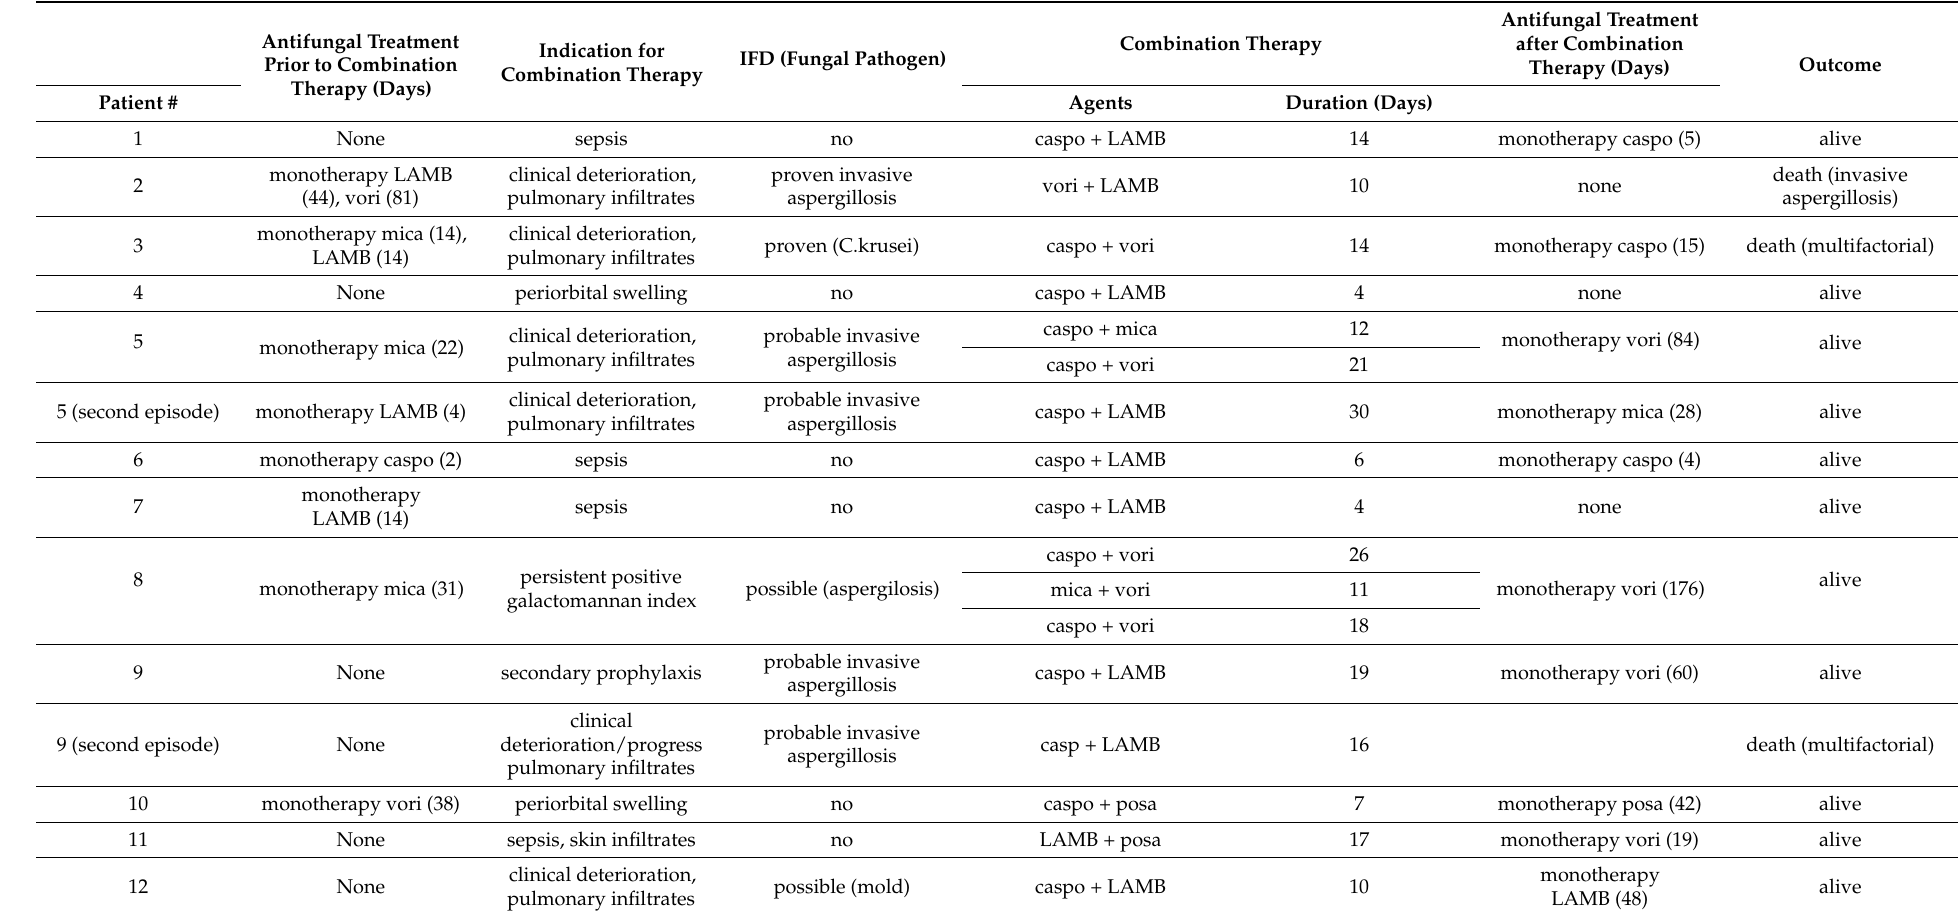
Table 2. Characteristics of antifungal combination therapy, clinical findings and